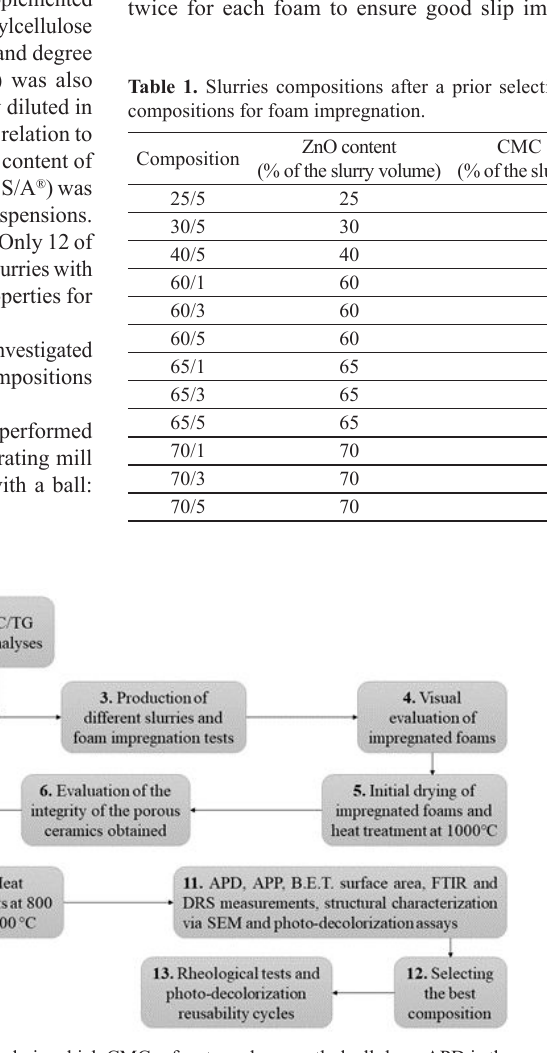
Figure 1. The processing steps performed in the research, in which CMC refers to carboxymethylcellulose, APD is the apparent density, APP is the apparent porosity, SEM is the scanning electron microscopy and DSC/TG are the exploratory differential calorimetry/ thermogravimetry analyses.